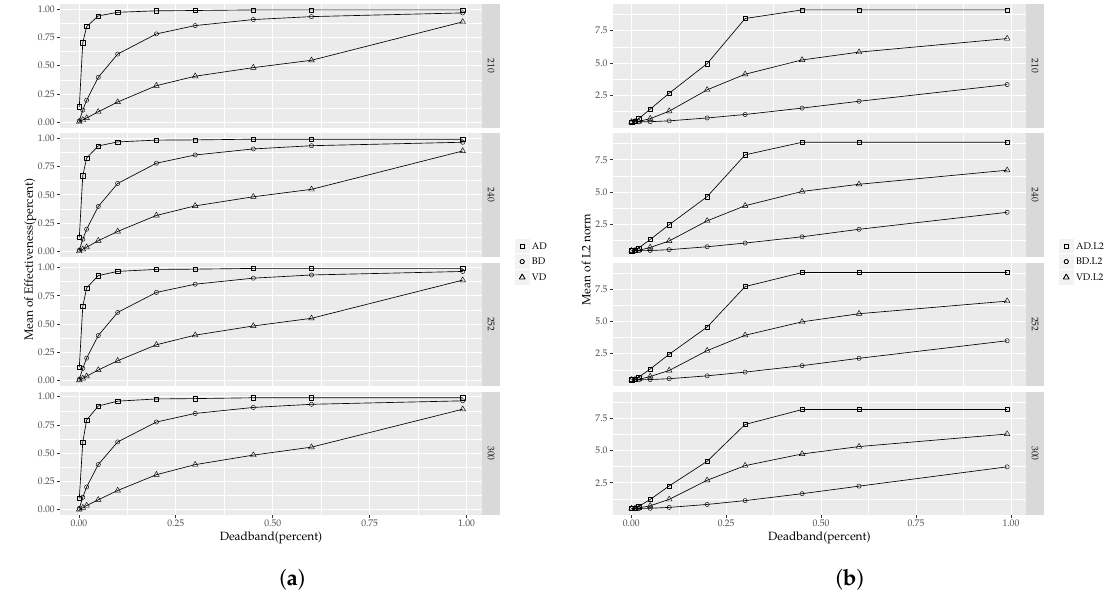
Figure 3. Effectiveness and L2 norm comparison for AD, VD and BD algorithms. ( a ) Mean of deadband effectiveness over all signals grouped by sampling rate; and ( b ) Mean of L2 norm over all deadband signals grouped by sampling rate.